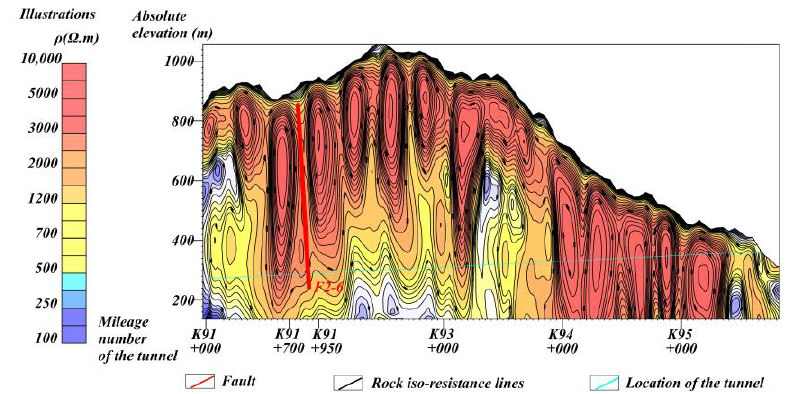
Figure 10. The relationship between the fault F2-5 and the tunnel section.